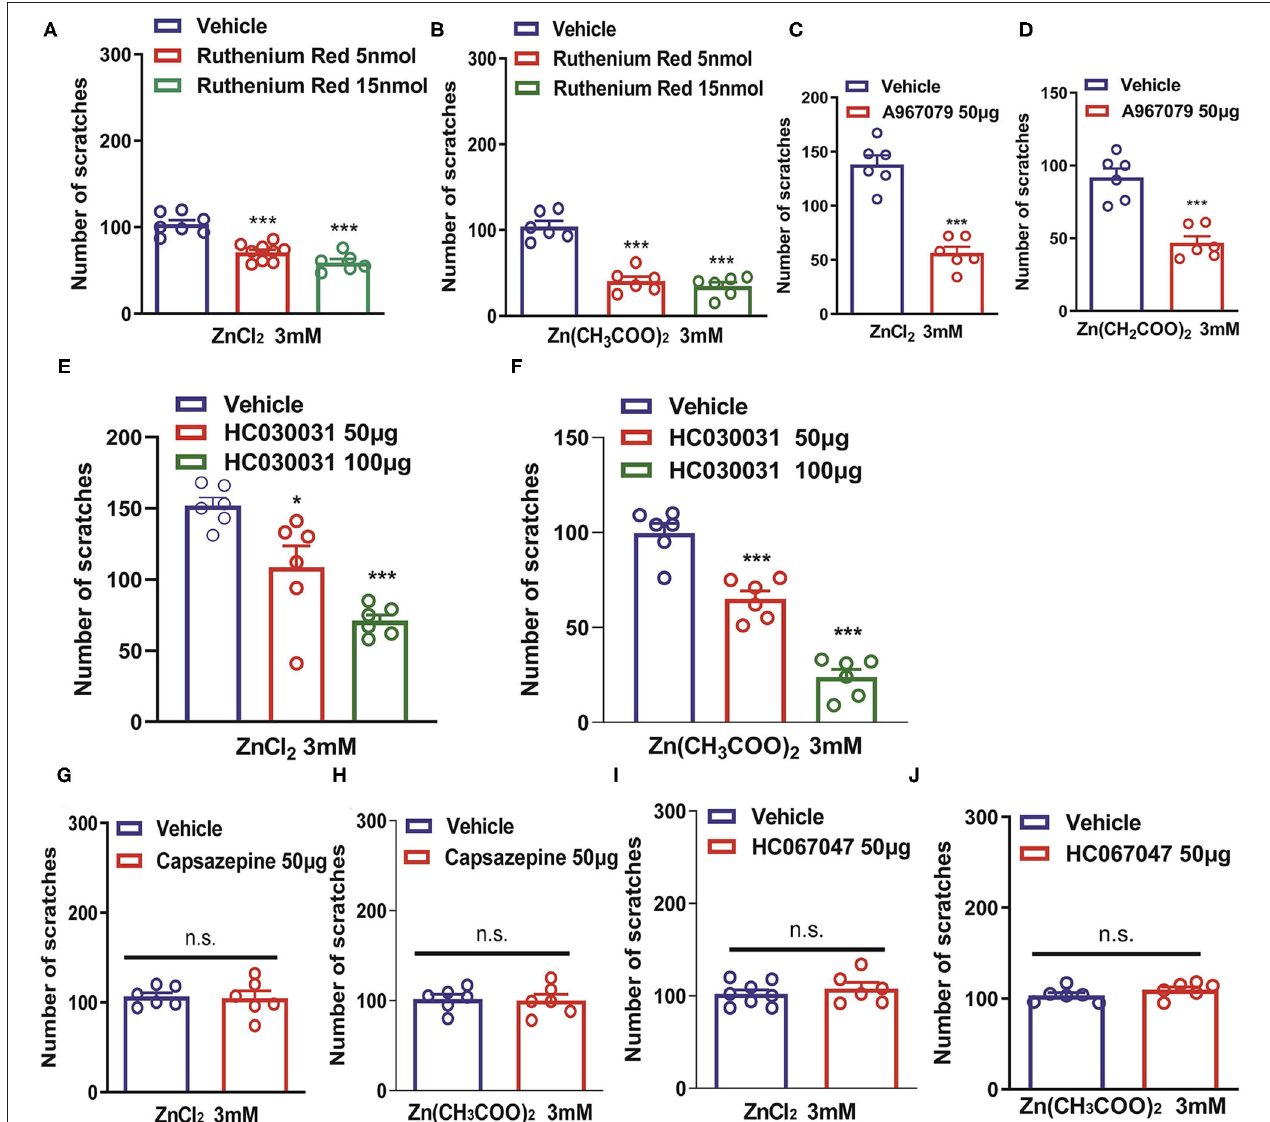
FIGURE 3 | Transient receptor potential A1 (TRPA1) is required for Zn 2 + -induced itch in mice. (A,B) The effects of coadministration of Ruthenium Red on ZnCl 2 (3mM)-induced (A) and Zn(CH 3 COO) 2 (3mM)-induced itch (B) in mice (*** P < 0.001 vs. Vehicle, one-way AVOVA following post-hoc Bonferroni’s test; n = 6–9 per group). (C,D) The effects of coadministration of a TRPA1 blocker, A967079 on ZnCl 2 [ (C) ; 3mM]-induced and Zn(CH 3 COO) 2 [ (D) ; 3mM]-induced itch in mice (*** P < 0.001 vs. Vehicle, unpaired Student’s t -test; n = 6–8 per group). (E,F) The effects of coadministration of a TRPA1 blocker, HC030031 (50 and 100 µ g) on ZnCl 2 - [ (E) ; 3mM] and Zn(CH 3 COO) 2 - [ (F) ; 3mM] induced itch in mice (* P < 0.05, *** P < 0.001 vs. Vehicle, one-way AVOVA following post-hoc Bonferroni’s test; n = 6–9 per group). (G,H) The effects of coadministration of a TRPV1 blocker capsazepine on ZnCl 2 [ (G) ; 3mM]- and Zn(CH 3 COO) 2 [ (H) ; 3mM]-induced itch in mice. (I,J)